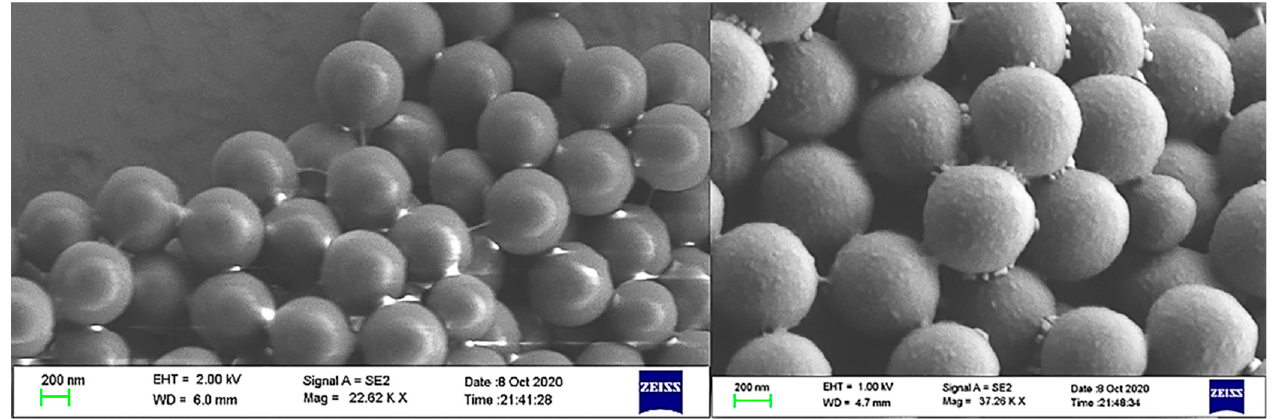
Figure 4. SEM image of the change in roughness before (the left one) and after(the right one) the microspheres are functionalized.